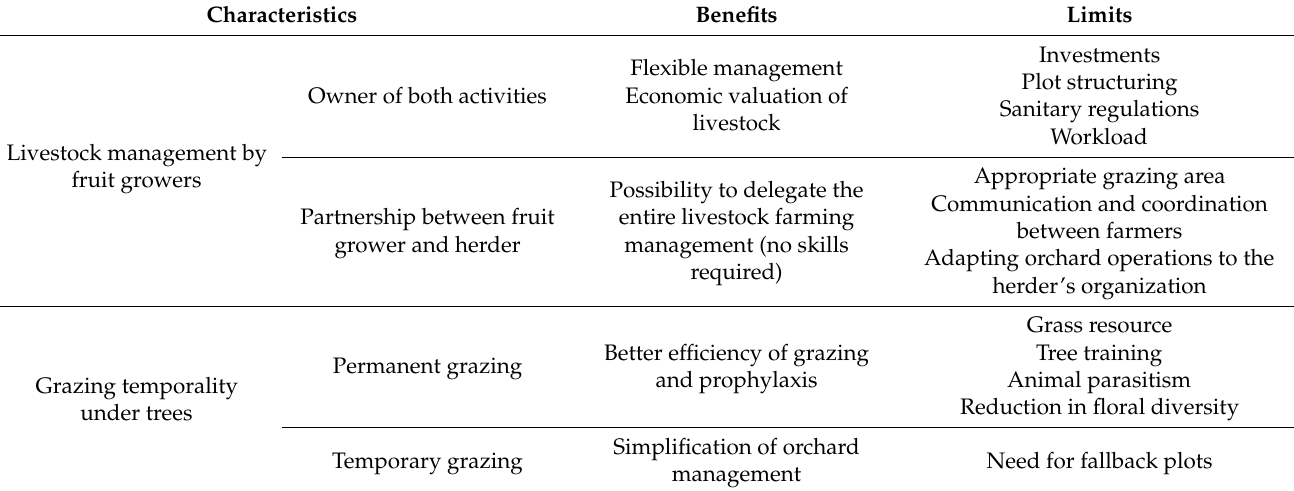
Table 2. Synthesis of the main characteristics of a grazed orchard management